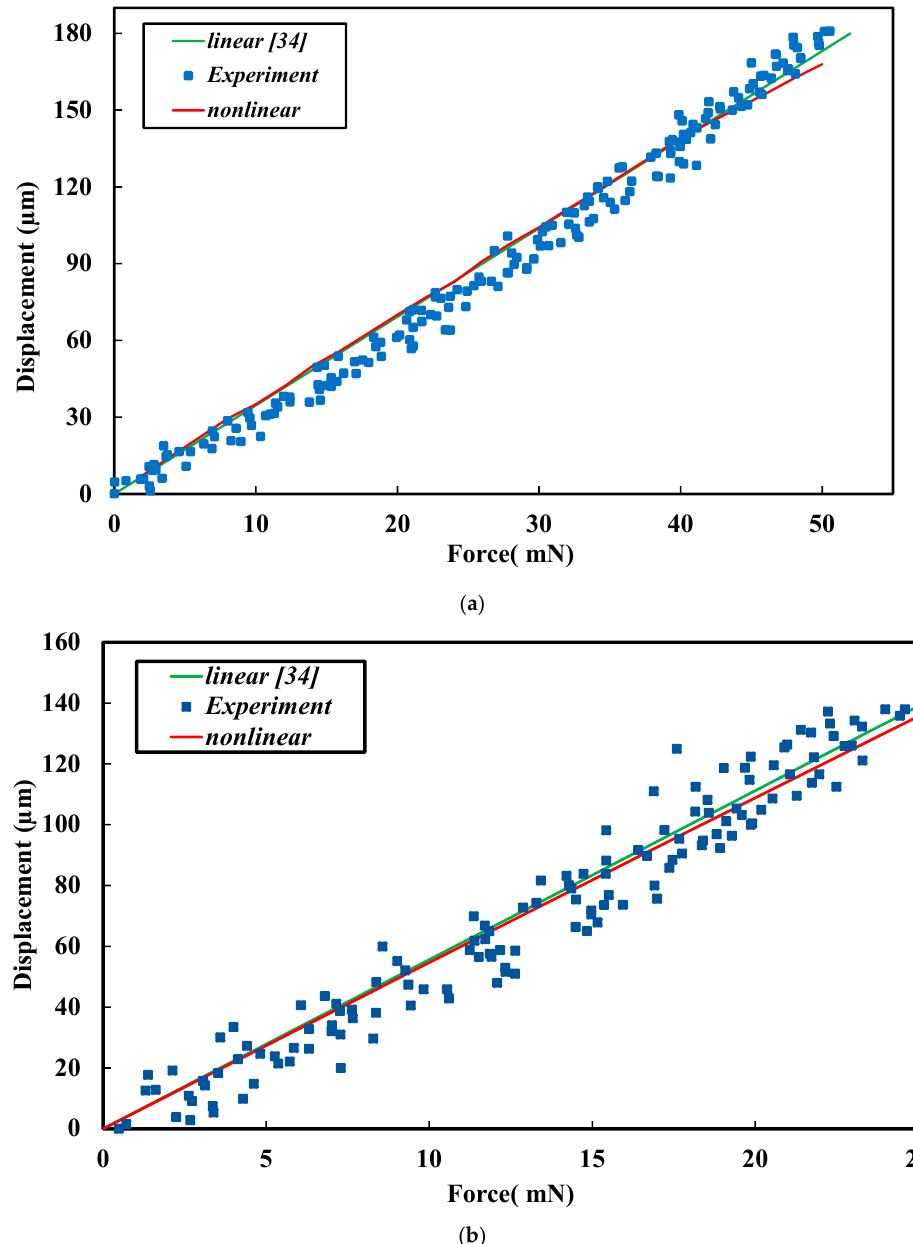
Figure 5. Comparison of linear and nonlinear models with experimental results in which N = 8, p = 80 μ m, l = 200 μ m, w = 40 μ m, and h = 100 μ m. ( a ) φ = 20°, ( b ) φ = 30°.